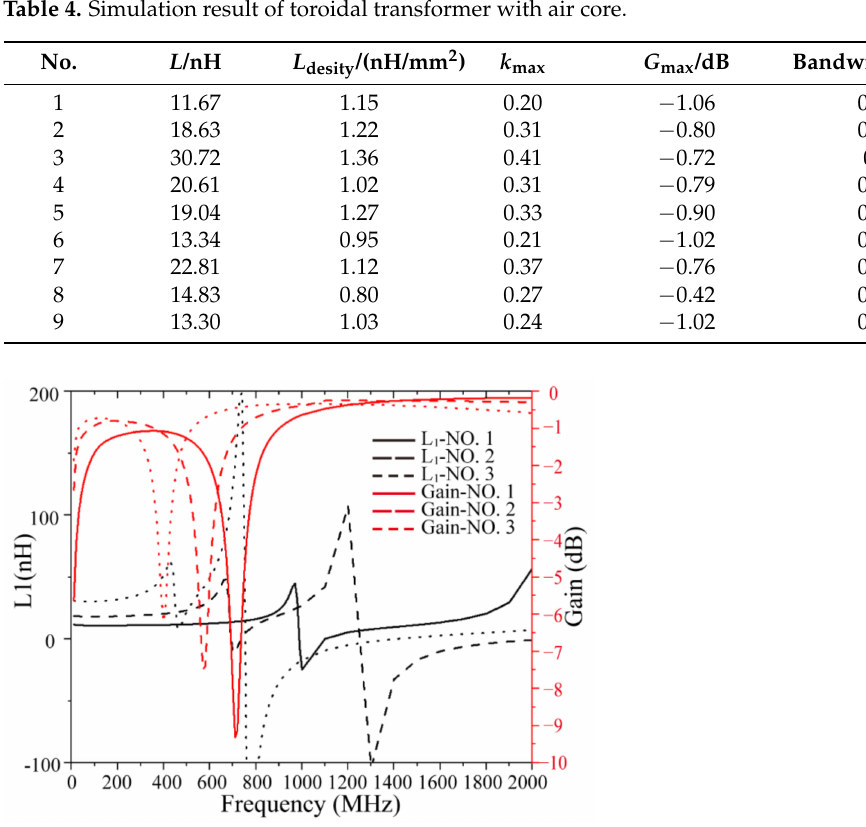
Figure 4. Inductance and maximum available gain of toroidal transformer with air